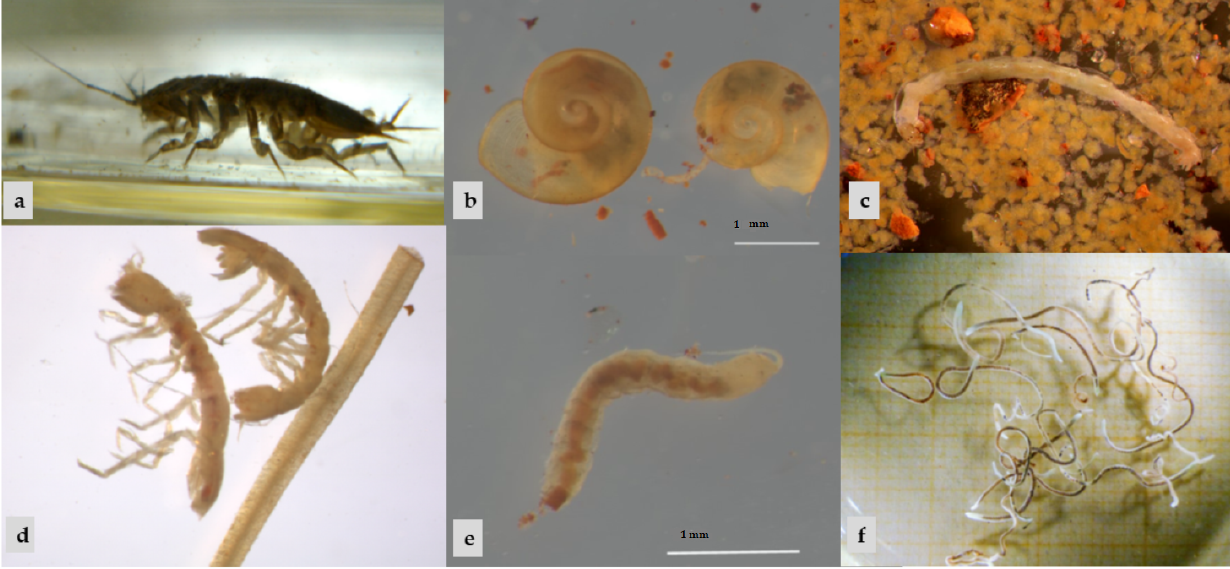
Figure 2. Macroinvertebrates in drinking water networks. ( a ): water lice ( Asellus aquaticus ), ( b ): Nautilus ramshorn ( Gyraulus crista ), ( c ): Chironomid larvae ( Paratanytarus grimmii) , ( d ): cave water louse ( Proasellus cavaticus ), ( e ): Oligochaete ( Stylaria lacustris ), ( f ): Oligochaete ( Lumbriculus variegatus ). Fotos© U. Michaels, G.